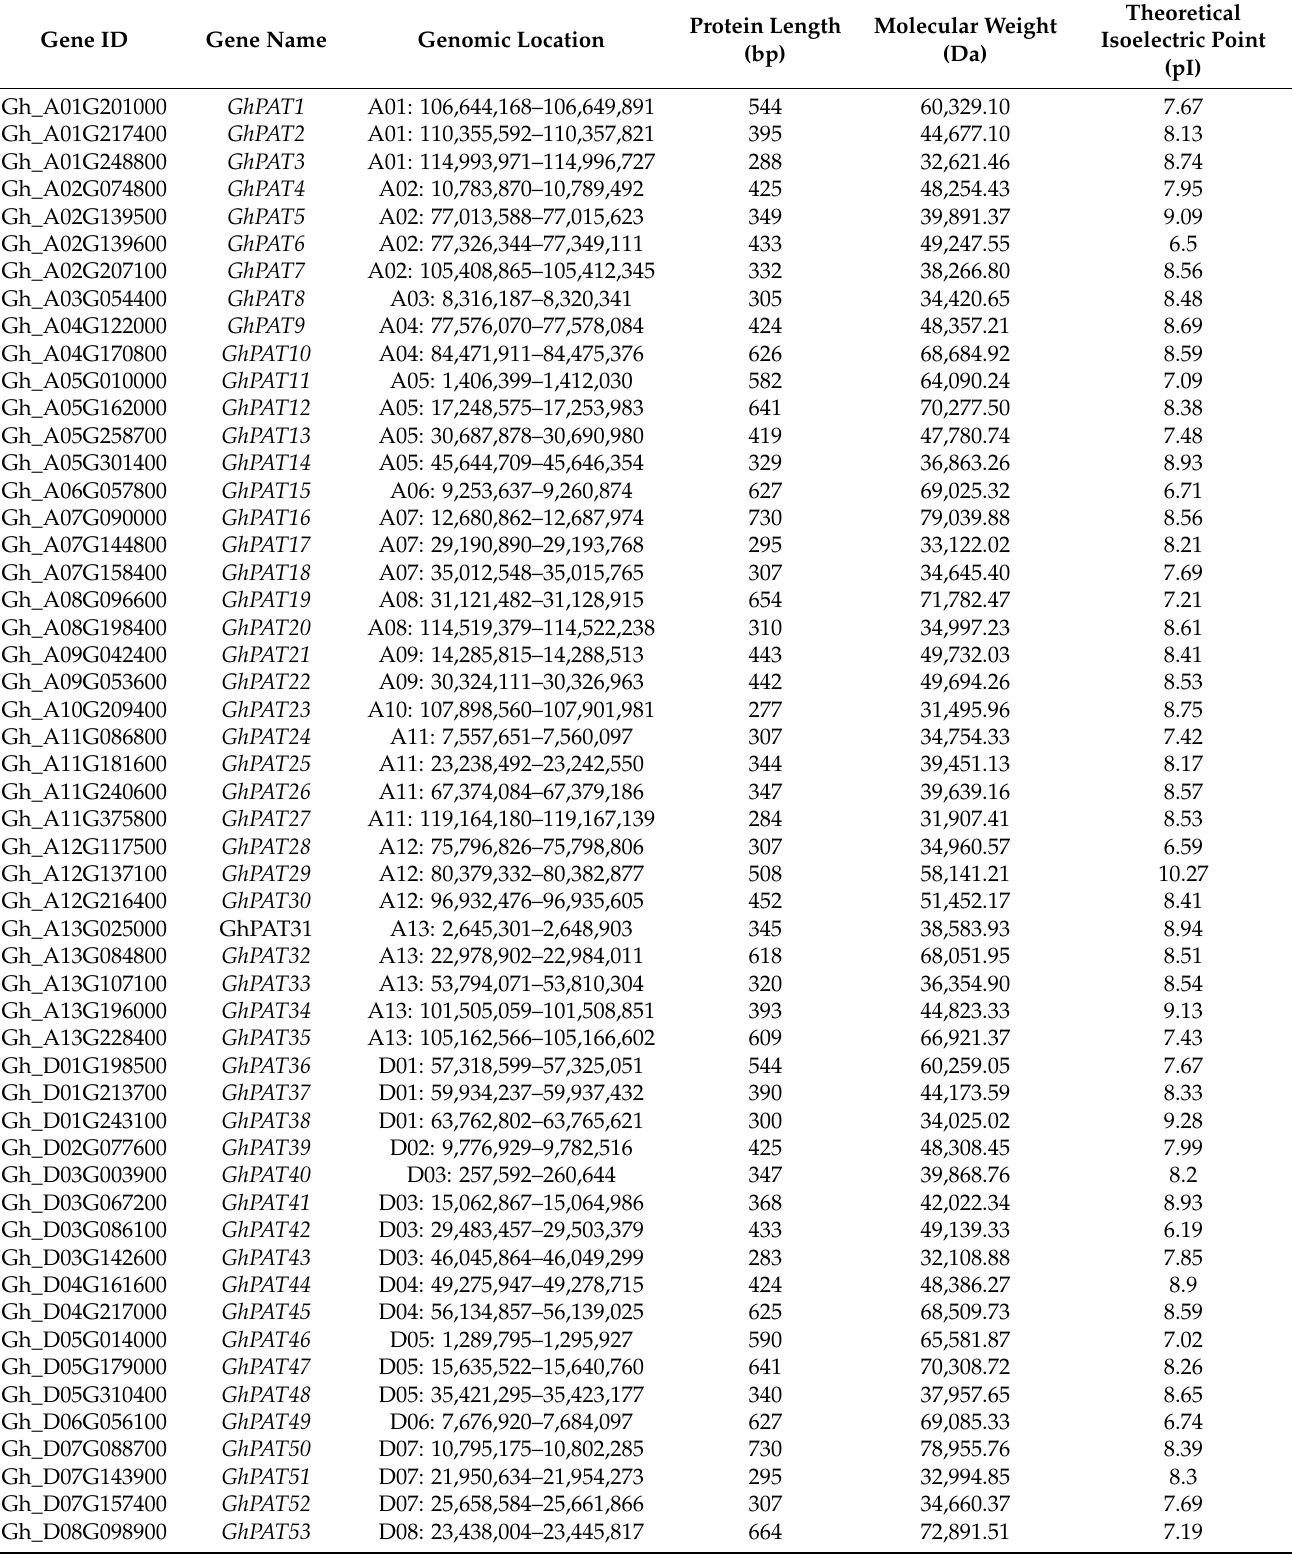
Table 1. Identification information for members of the GhPAT gene